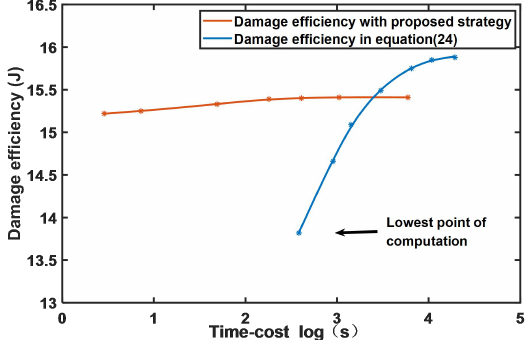
Figure 9. Damage efficiency under different